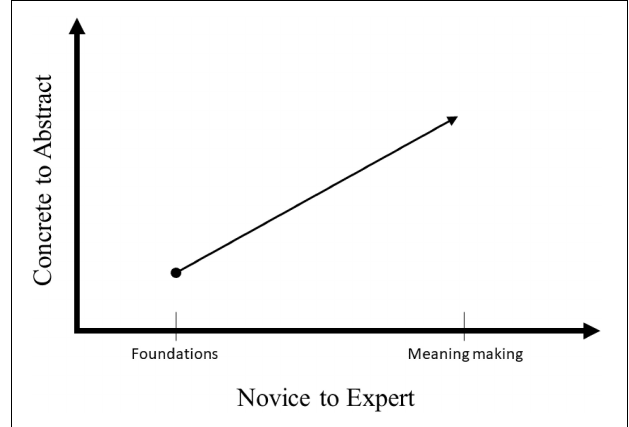
FIGURE 1 | Mastery learning progression. This figure indicates the novice to expert continuum in a mastery learning